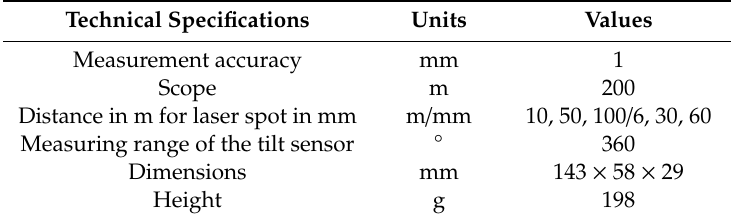
Table 3. Technical specifications of the Leica Disto D510 (E7500i) digital laser distance